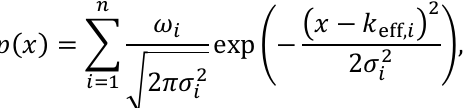
a target system and benchmark critical experiment systems, (2) experimental uncertainties of